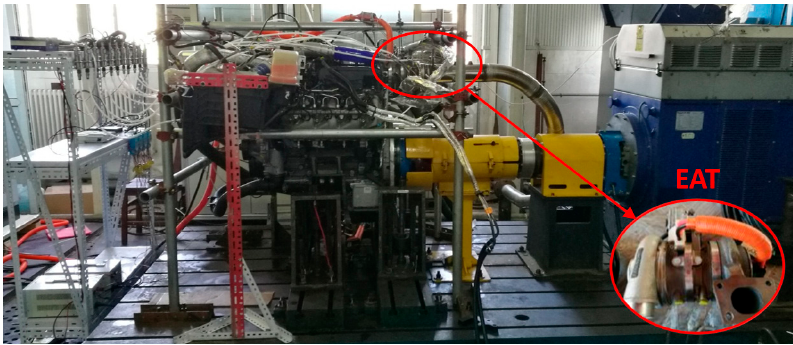
Figure 3. Test bench for diesel engine with EAT. Table 3. Specifications of test bench.